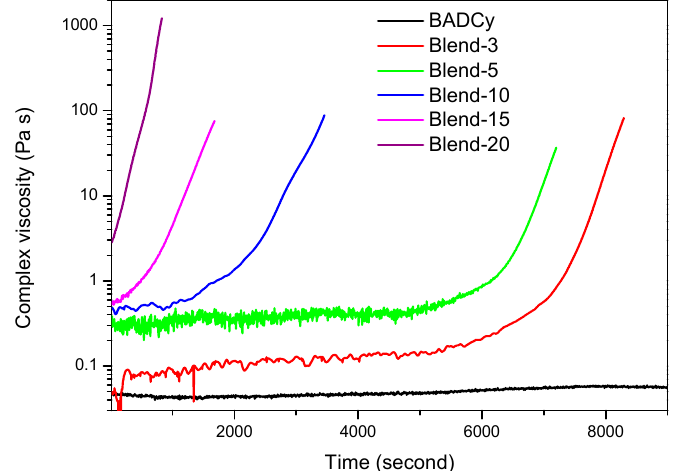
Figure 3. Curing behavior of BADCy and TPI/BADCy blends at 200 °C.